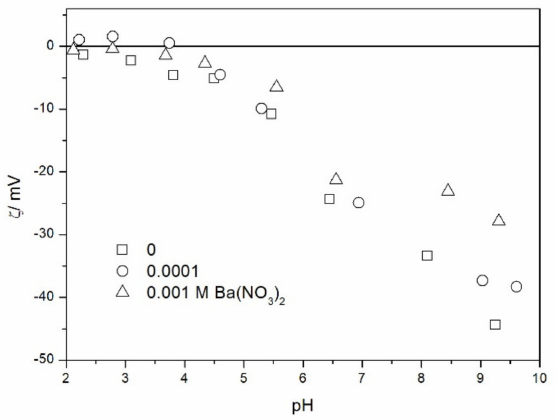
Figure 10. The zeta potential of TeO 2 in the presence of barium and 0.001 M